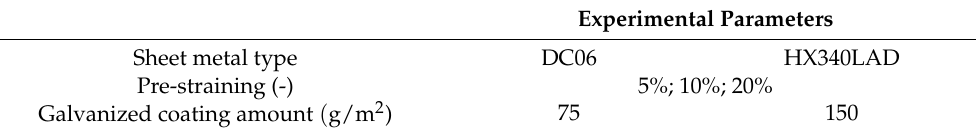
Table 3. Test matrix for verification of the influence of sheet coating on strain-induced roughening.